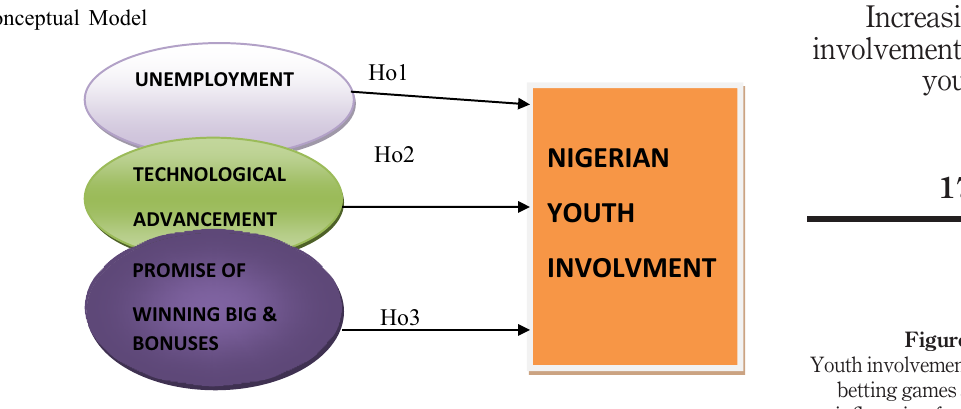
Figure 1. Youth involvement